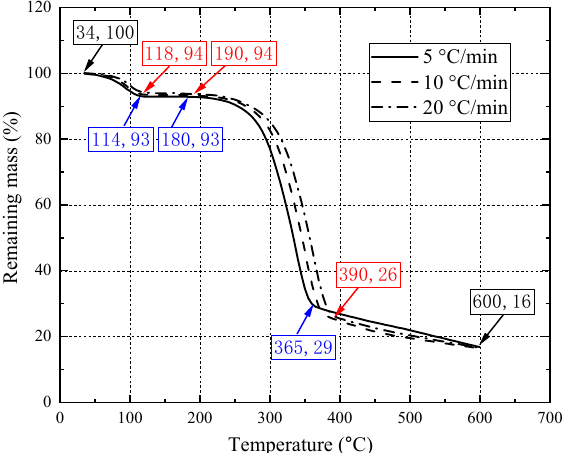
Figure 3. TGA test results at 5, 10 and 20 °C/min.